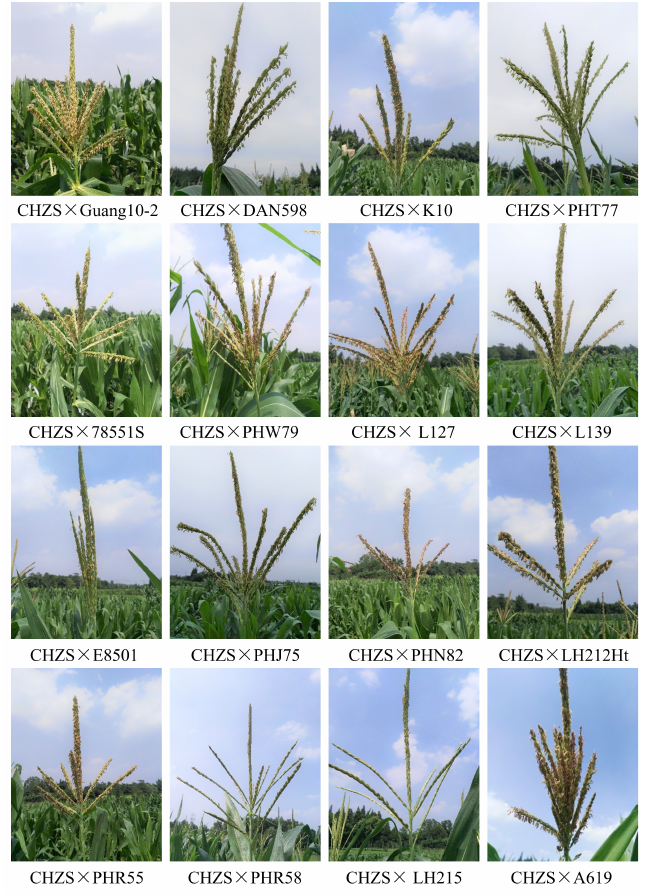
Figure 2. Fertility performance of F 1 crosses of CHZS and tester